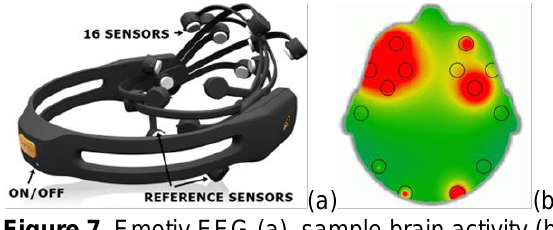
Figure 7. Emotiv EEG (a), sample brain activity (b)